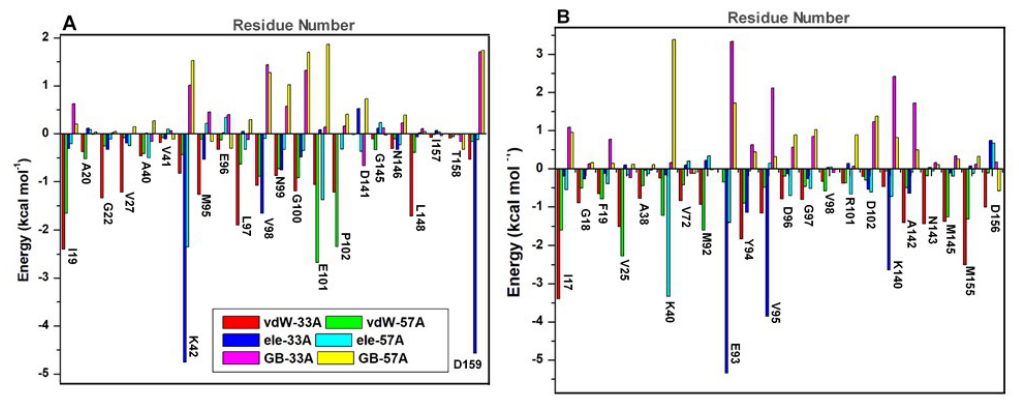
Figure 12. Energy ( ΔG bind ) decomposition on a per-residue basis into contributions from the van der Waals, electrostatic and polar solvation (ΔG ele,sol (GB) ) energies for crucial NBP residues. ( A ) ΔG bind per-residue energy contributions of catalytic components in PknA nucleotide binding pocket ( B ) Per-residue energy contributions of catalytic components in PknB nucleotide binding pocket.